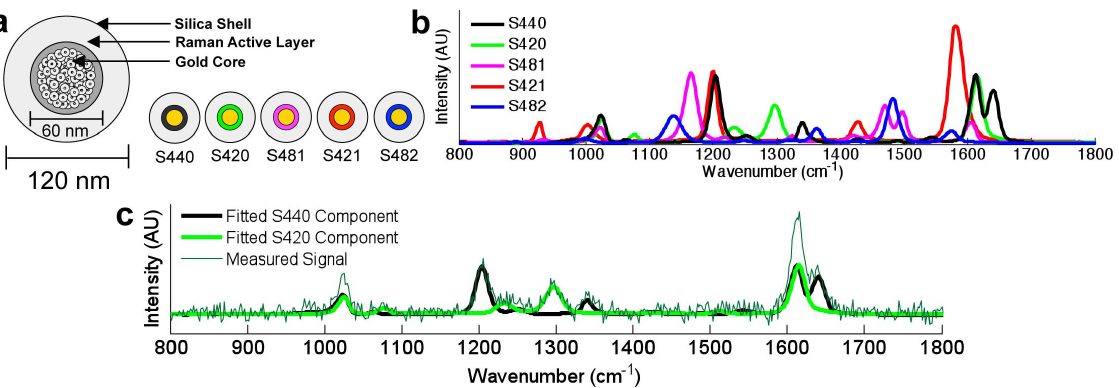
Figure 1. Surface-enhanced Raman scattering (SERS) nanoparticles. (a) Multiple flavors of nanoparticles exist where each nanoparticle contains a gold core coated with a Raman-active layer, encased in a silica shell. (b) Raman spectra of five nanoparticle flavors. (c) Example result from a least-squares routine showing the ability to demultiplex two different nanoparticles from a mixture under noisy conditions.